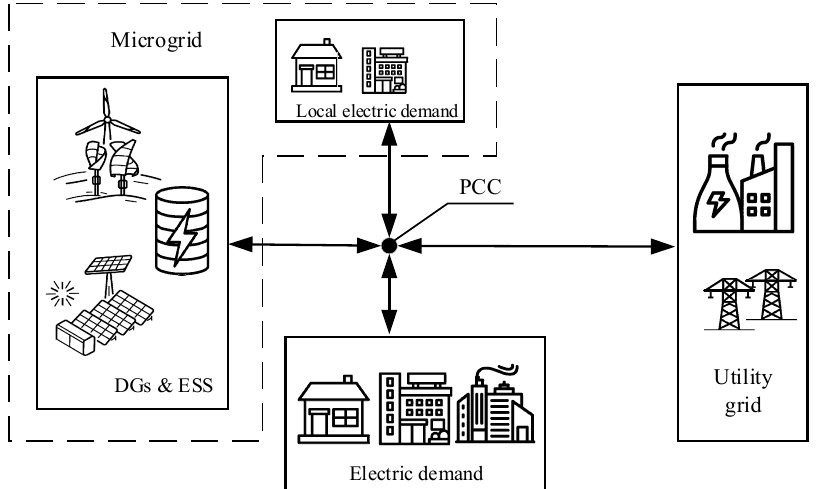
Figure 1. Simplified diagram of a distribution network with a microgrid (own elaboration based on data from